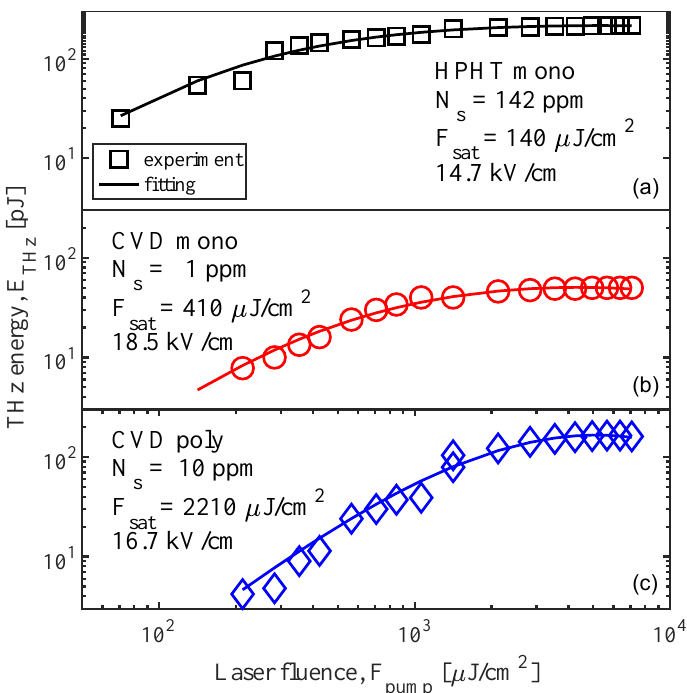
Figure 4. Experimental dependence of THz energy (dots) emitted by different diamond PCAs on the optical laser fluence: ( a ) HPHT diamond (high nitrogen level), ( b ) monocrystalline CVD diamond (low nitrogen level) and ( c ) polycrystalline CVD diamond (moderate nitrogen level). Solid lines designate curves that were fitted according to Equation (3).